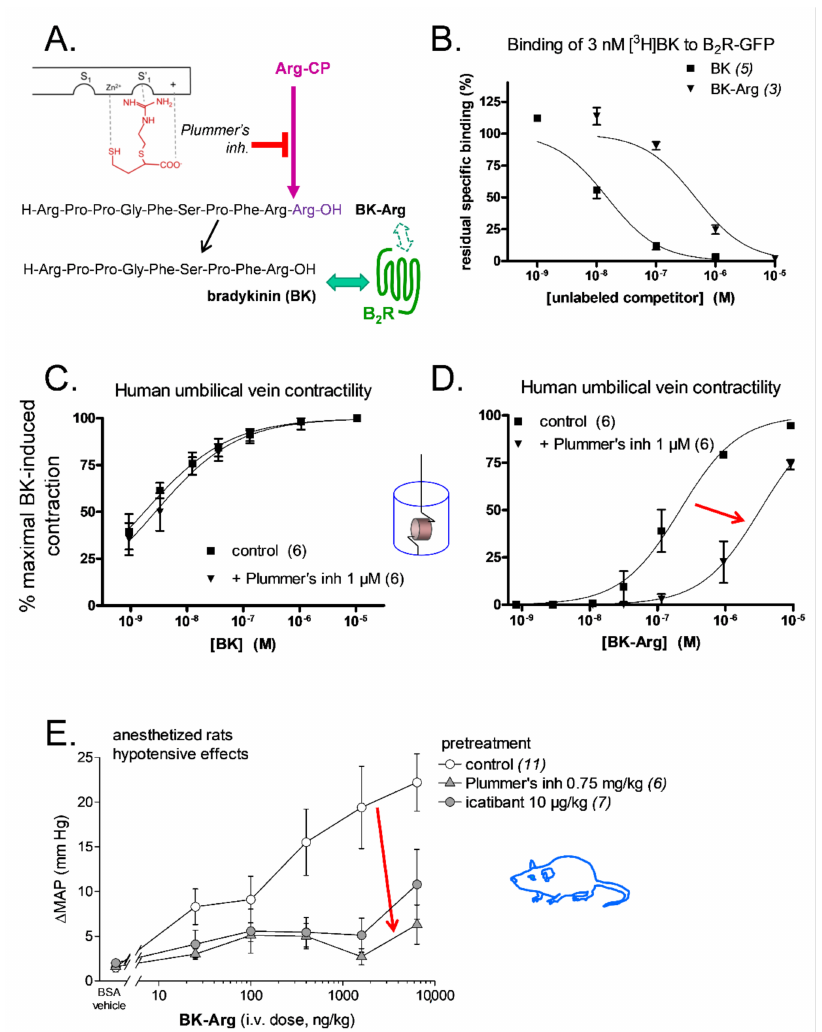
Figure 5. Bradykinin C-terminally prolonged by Arg (BK-Arg), an example of a peptidase-activated latent B 2 R agonist. ( A ) BK-Arg is designed to be activated by widely distributed arginine carboxypep- tidases (Arg-CP); Plummer’s inhibitor is an arginine analog that inhibits these peptidases with selectivity. ( B ) BK-Arg has a low affinity for the B 2 R, as evidenced by the competition of the [ 3 H]BK binding to a recombinant form of the B 2 R in an assay conducted at 0 ◦ C. ( C , D ) Plummer’s inhibitor has no significant effect on the potency of BK in the umbilical vein contractility assay, whereas it reduces that of BK-Arg 15-fold, supporting its metabolism into BK in the tissue. E. In anesthetized rats, the hypotensive effect of BK-Arg (measured as the maximal drop of mean arterial pressure, ∆ MAP) is inhibited by pretreatment with either Plummer’s inhibitor or the B 2 R antagonist icatibant. Plummer’s inhibitor had no effect on the hypotensive effect of BK [73] or on the contractile effect of BK ( C ) because Arg-CPs are a minor metabolic pathway for BK inactivation. Red arrows ( D , E ) emphasize the effect of Arg-CP blockade. Modified from [73] ( A , E ) and [89] ( B – D ). Values are means ± s.e.m. of the numbers of replicates indicated between